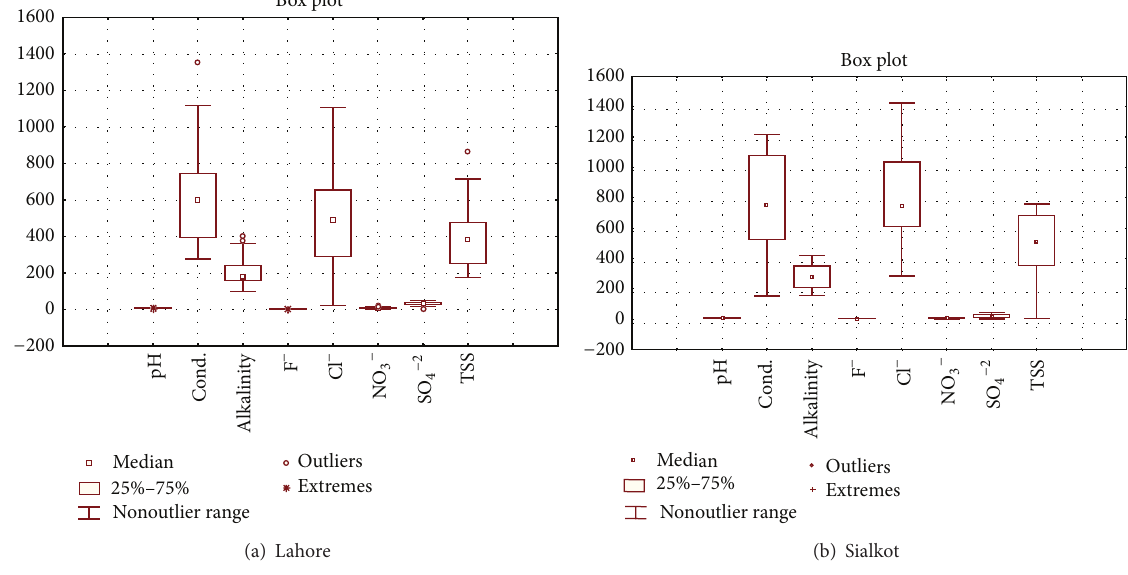
Figure 3: Box plot for parameters from drinking water samples for Lahore and